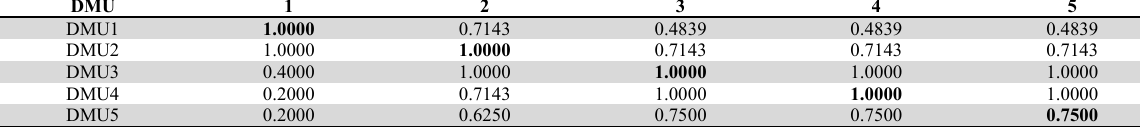
RCB cross-efficiency matrix (RCB-CEM) of performance assessment problem DMU